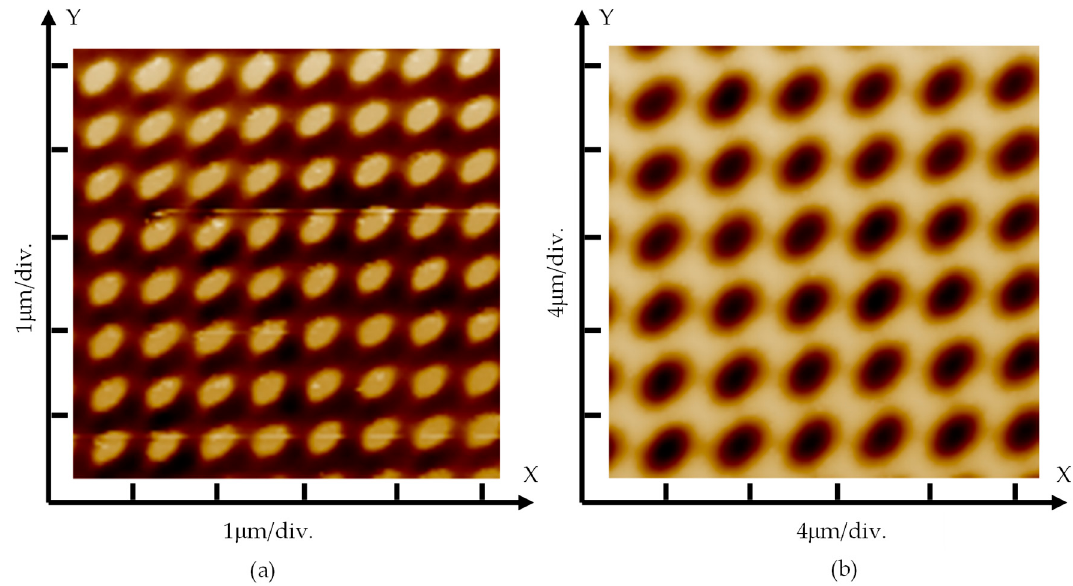
Figure 8. AFM images of fabricated grating without polarization under different incident angle θ shown in Figure 2: ( a ) 60° and ( b ) 85°.